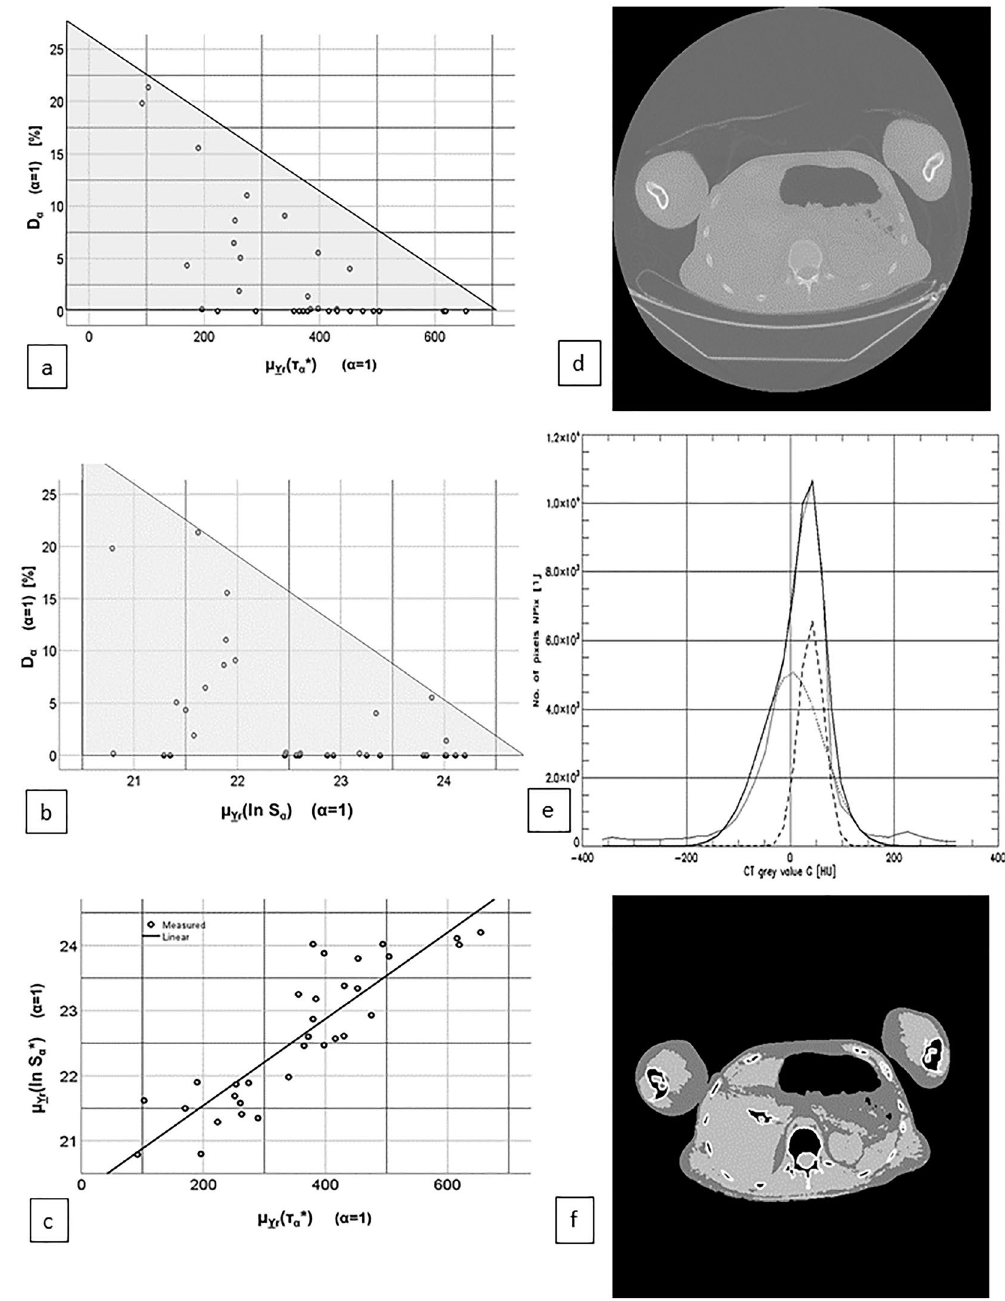
Figure 2. ( a ) Scatterplot: FM misclassification rate D α and mean FM separability μ Yr (τ α *) of all individual scans Y r in the sample Ψ for α = 1. Triangle inserted to show non-function type relation. ( b ) Scatterplot: FM misclassification rate D α and mean log WLS distance μ Yr (ln S α ) of all individual scans Y r in sample Ψ for α = 1. ( c ) Scatterplot: mean log WLS distance μ Yr (ln S α ) and mean FM separability μ Yr (τ* α ) of each individual scan Y r in the sample Ψ with α = 1. The drawn line represents a linear model fitted with by a least square approach. ( d ) Example slice from scan LFD_5: Original CT slice. ( e ) Example slice from scan LFD_5: Grey value histograms: measured: X (thin line), fitted: X(Θ) (fat line), partial fat: X F (Θ) (dotted line), partial muscle X M (Θ), fat vertical line: threshold t FM . ( f ) Example slice from scan LFD_5: Quasi segmented image (light grey: muscle, dark grey: fat, white boundary area: bones), the weight exponent was α =